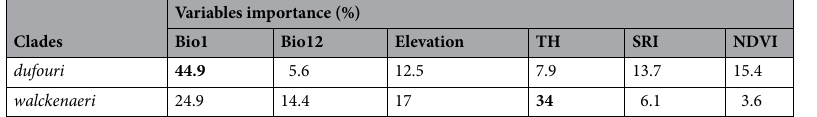
Table 1. Results of variable importance for the two clades ( dufouri and walckenaeri ). Significant values are in bold. NDVI normalized difference vegetation index, TH topographic heterogeneity, SRI solar radiation index.